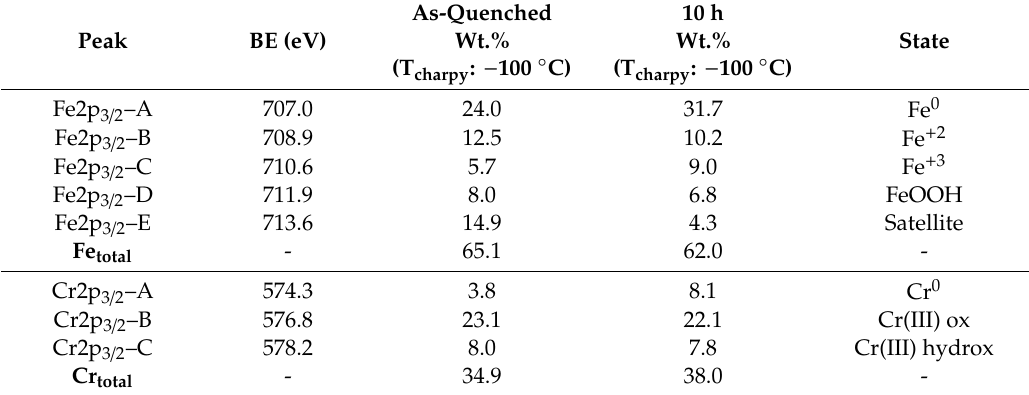
Table 4. Binding energy, X-ray photoelectron spectroscopy (XPS) quantification and chemical states of Fe and Cr of the samples broken in brittle field.